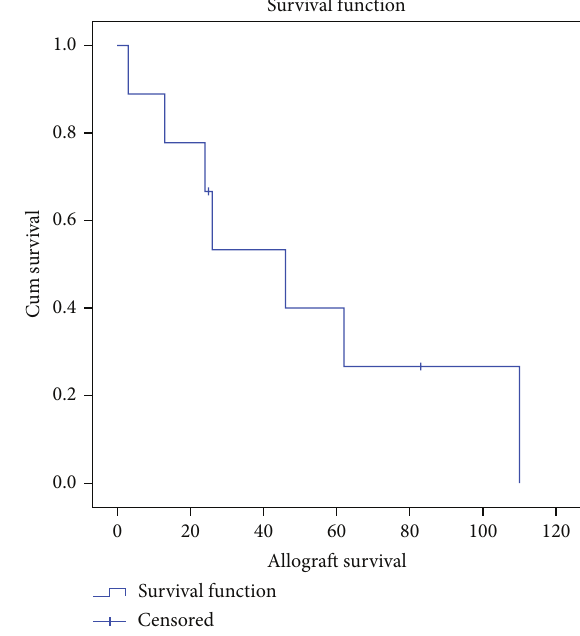
Figure 3: Kaplan-Meier analysis diagram demonstrating the allo- graft survival with the allograft removal as an